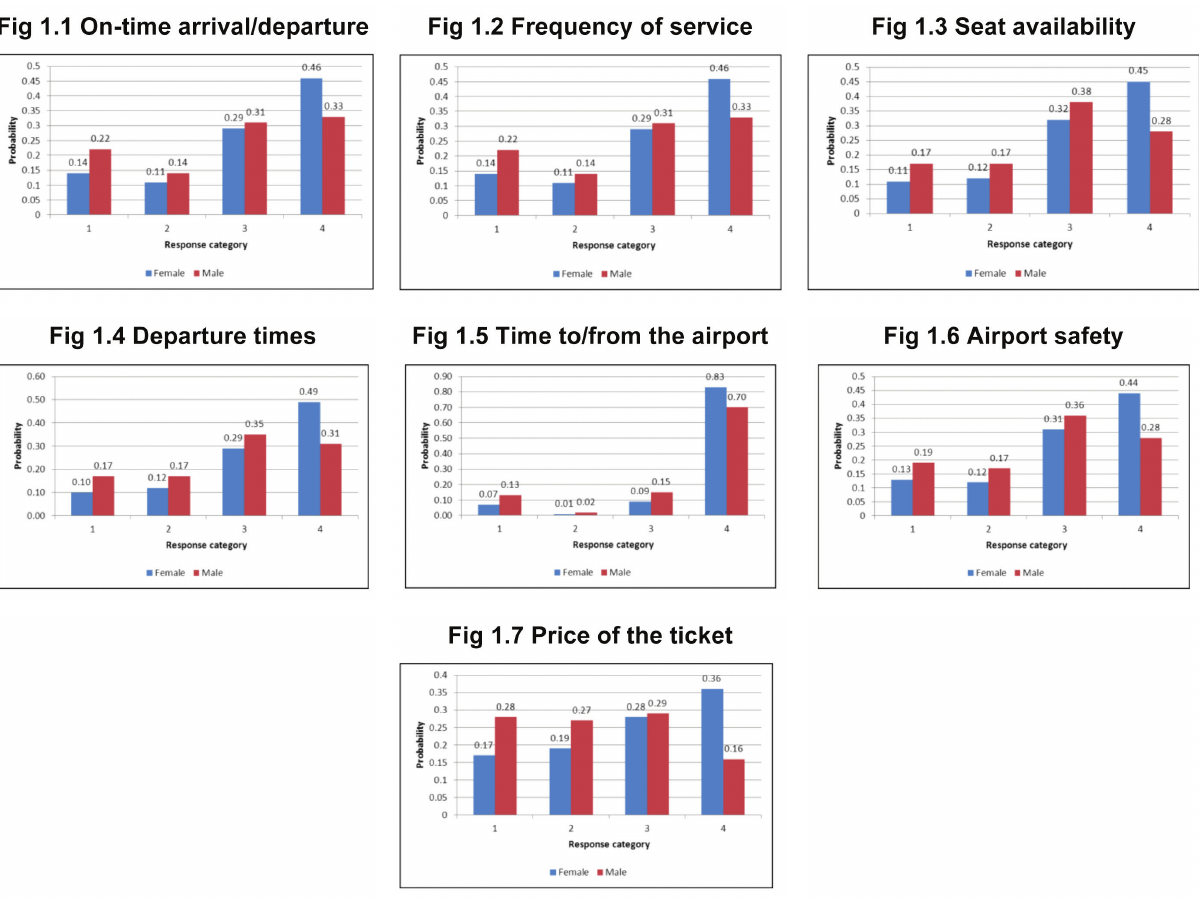
Figure 1: Response category probabilities by